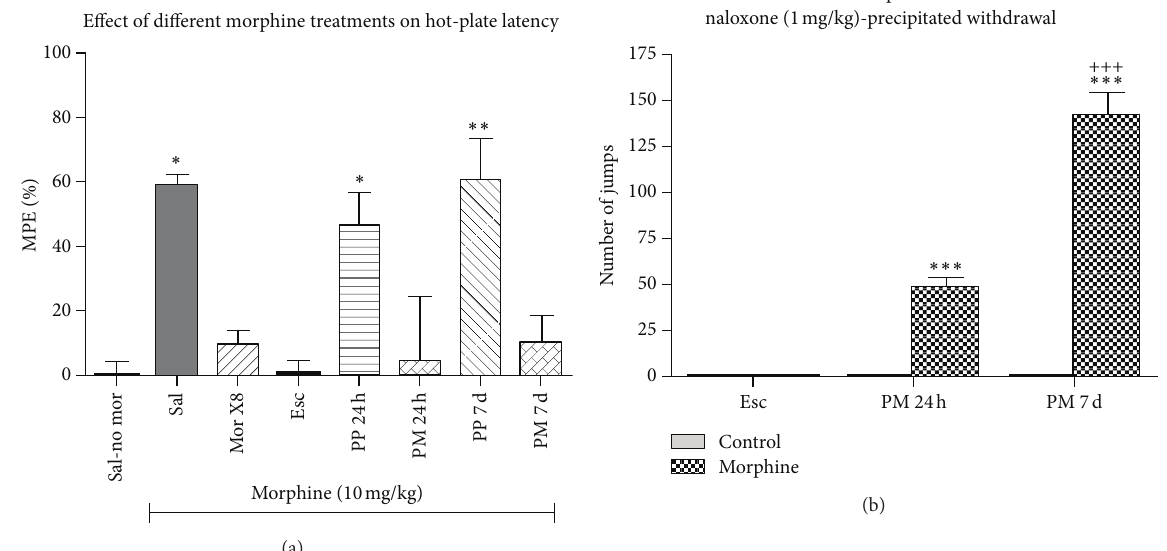
Figure 1: Percent maximum possible effect (%MPE) (a) and naloxone-precipitated withdrawal jumping (b) following different treatments. In hot plate latency testing (a), Sal-no morphine (Sal-no mor) group received saline (s.c.) and was tested for hot plate latency 30 min later. All other groups received their treatment and were then given morphine (10mg/kg, s.c.) followed by hot plate latency testing 30 min later. See Table 1 for details on the morphine treatment paradigm. # 𝑃 < 0.05 , versus saline-no mor, ∗ 𝑃 < 0.05 , versus saline with morphine given 30 min after. 𝑁 = 5 – 9 per treatment. In naloxone-precipitated withdrawal (b), mice received either escalating dose of morphine or morphine pellet for 24h or 7 days or corresponding controls and then received naloxone (1mg/kg, s.c.) to precipitate withdrawal, which was determined by counting the mean number (± SEM ) of jumps over the next two h. The number of jumps in control treated mice was too small to be seen on the figure. ∗∗∗ 𝑃 < 0.01 , versus escalating dose. # 𝑃 < 0.001 , versus PM24h. 𝑁 = 6 - 7 per treatment.